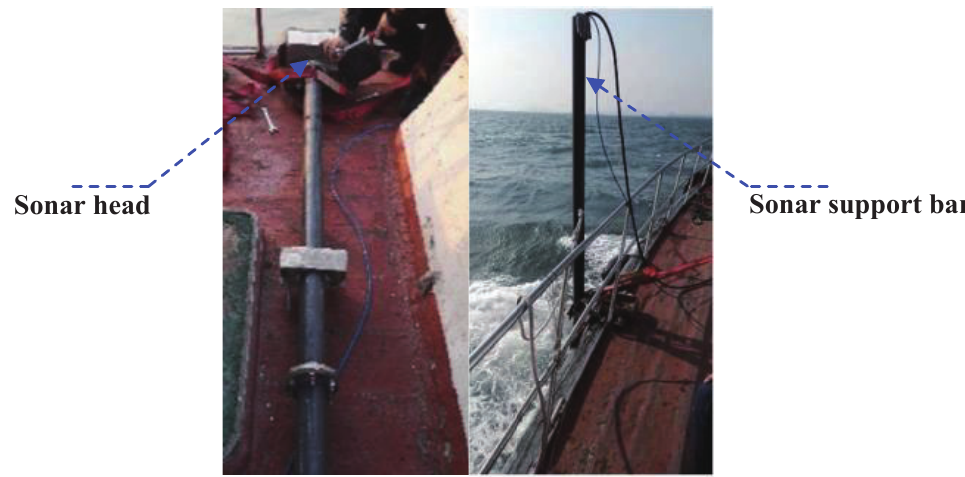
Figure 7. The installation location of MBES equipment on the survey